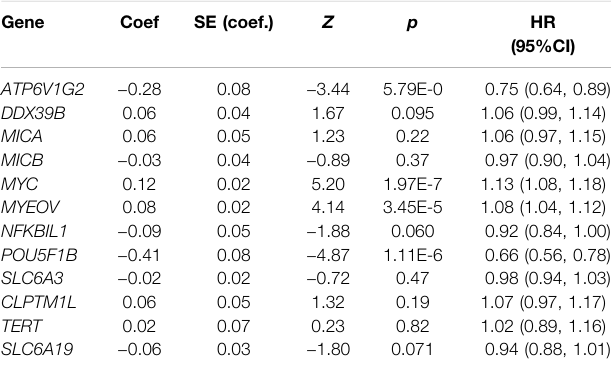
TABLE 4| Summaryofthemultivariable Coxregressionconductedon12CAPER genes in the TCGA training set *. Gene Coef SE (coef.)